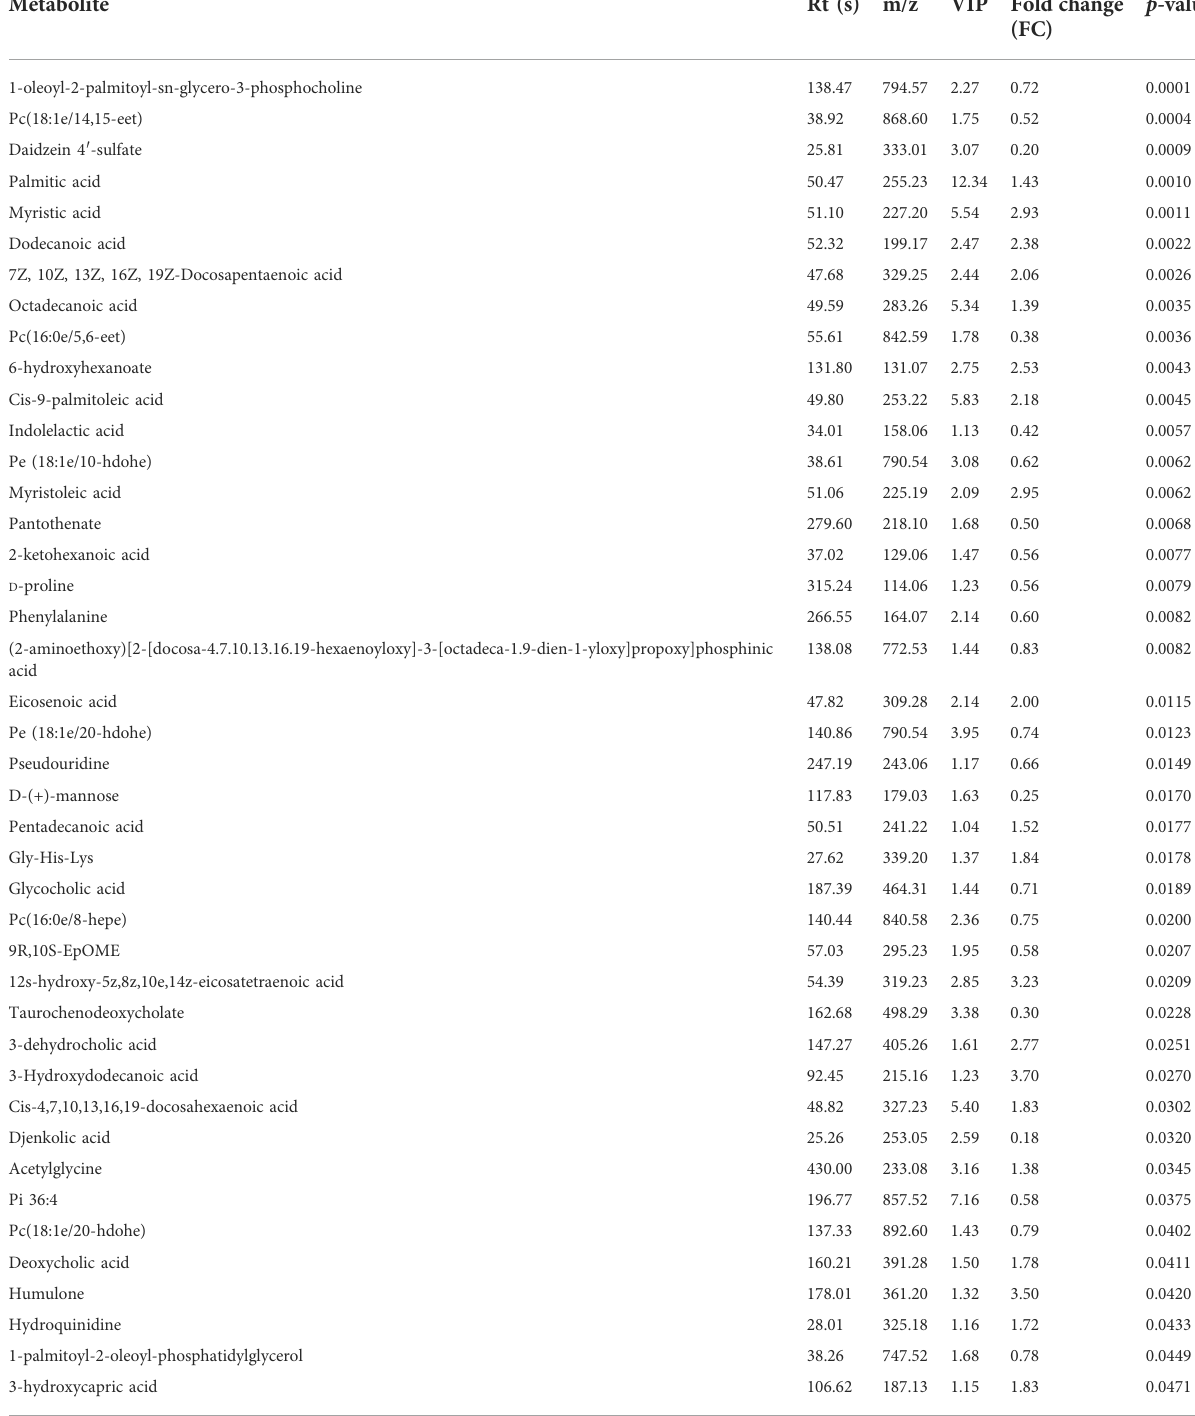
TABLE 1 Identi fi ed differentially expressed metabolites between HGWD-treated and control groups of mice (negative ion).